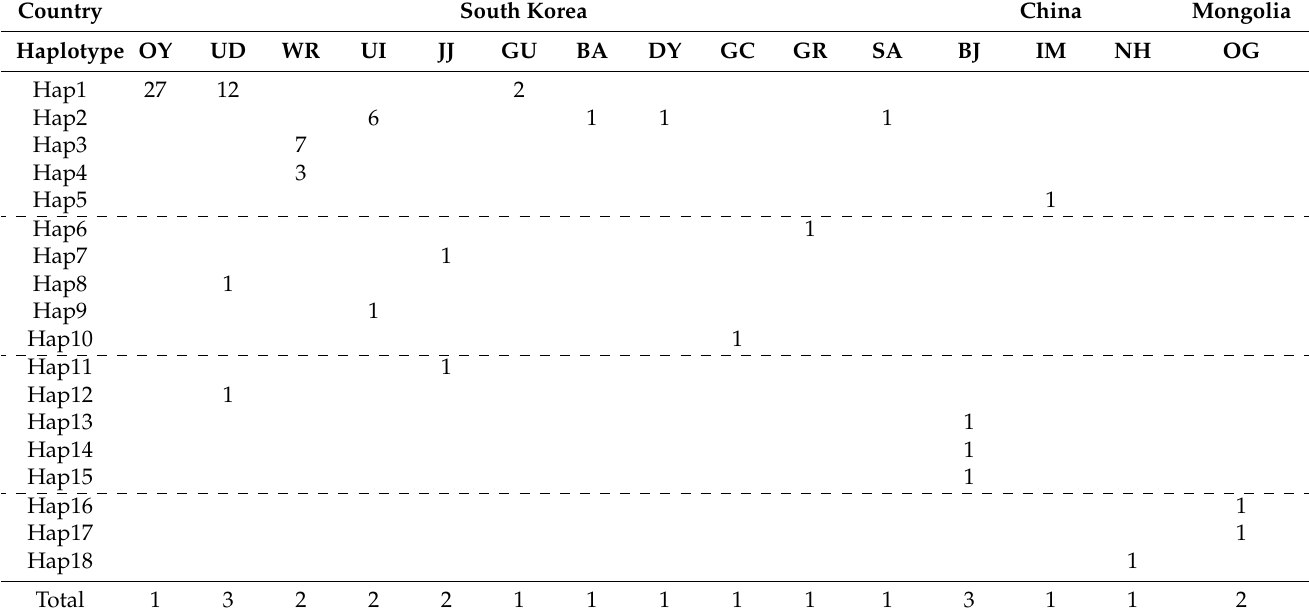
Table 2. Distribution of the concatenated mitochondrial DNA ( Cytb + ND4 ; 1809 bp) haplotypes of Orientocoluber spinalis across 11 South Korean populations, 3 Chinese populations, and 1 Mongolian population. OY, Oeyeondo; UD, Udo; WR, Woraksan; UI, Uido; JJ, Jejudo; GU, Gauido; BA, Buan; DY, Danyang; GC, Gochang; GR, Goryeong; SA, Shinan in South Korea, BJ, Beijing; IM, Inner Mongolia; NH, Ningxia in China; OG, Omnogovi in Mongolia. South Korea China Mongolia